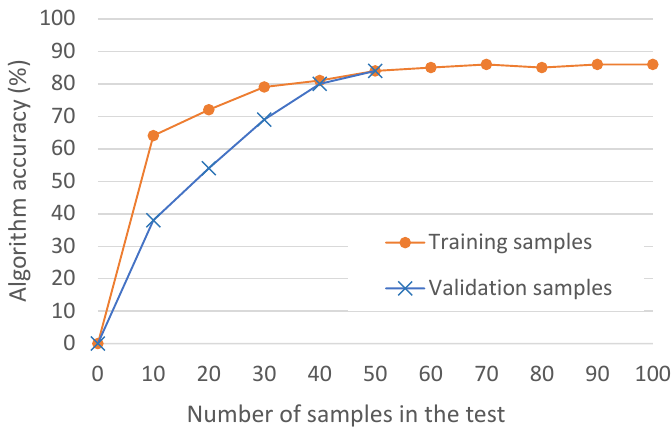
Figure 6. Accuracy of ML 1 for increasing number of training samples and validation samples.